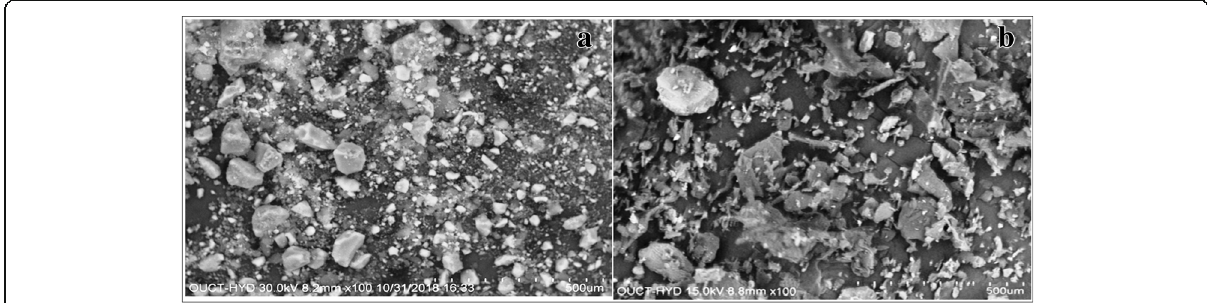
Fig. 5 SEM images of pure ZT ( a ) and optimized lyophilized ZT-SLN formulation ( b )